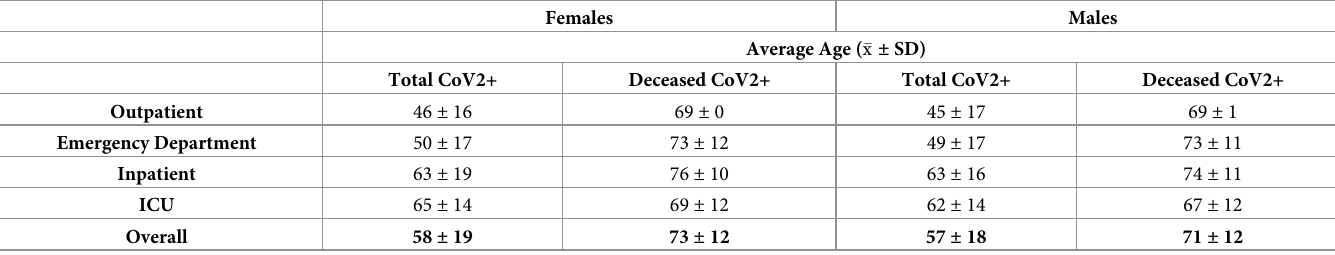
Table 5. Age comparison by gender across